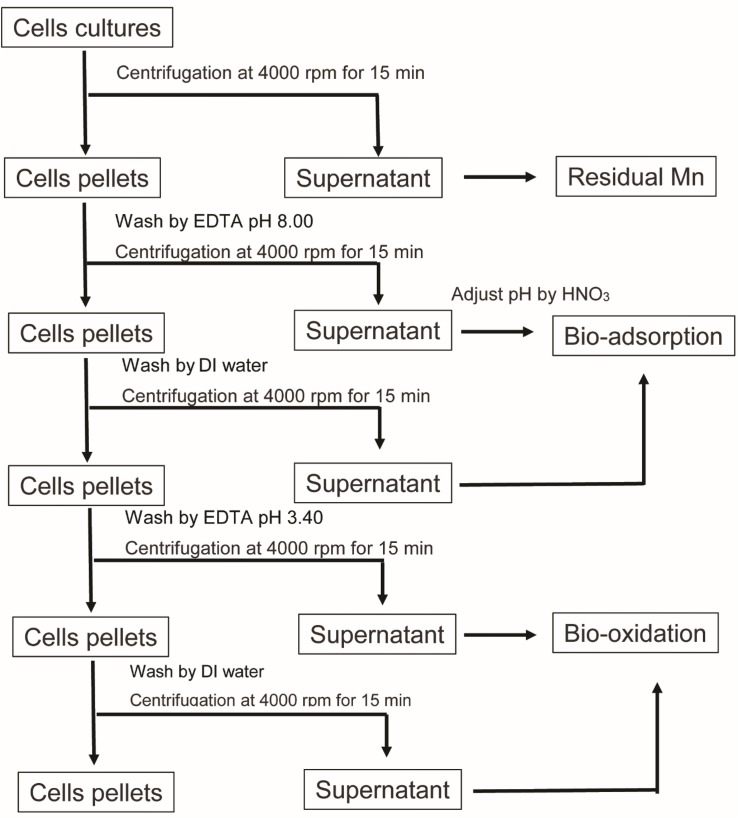
Schematic diagram representing the Mn content analysis in each portion of the remediation.